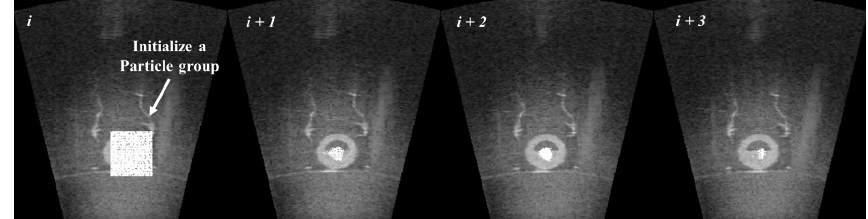
Figure 9. Convergence of particles at the